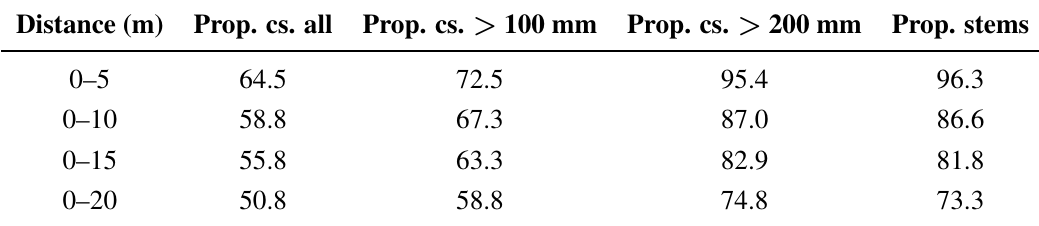
Table 2. Proportion (%) of detected trees at different distances for cross-sections (cs.) of different sizes and tree stem positions